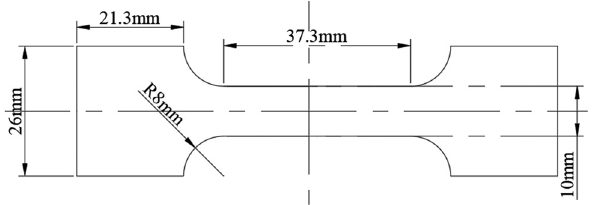
Figure 1: Dimensions of non - standard tensile